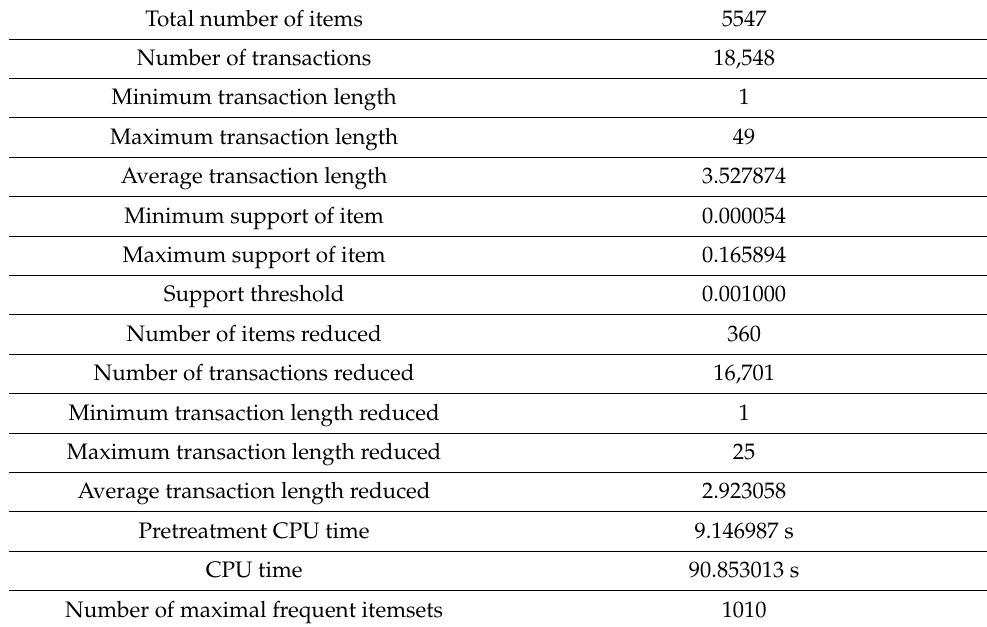
Figure 3. Support of supermarket data. Table 2. Parameters of supermarket data.